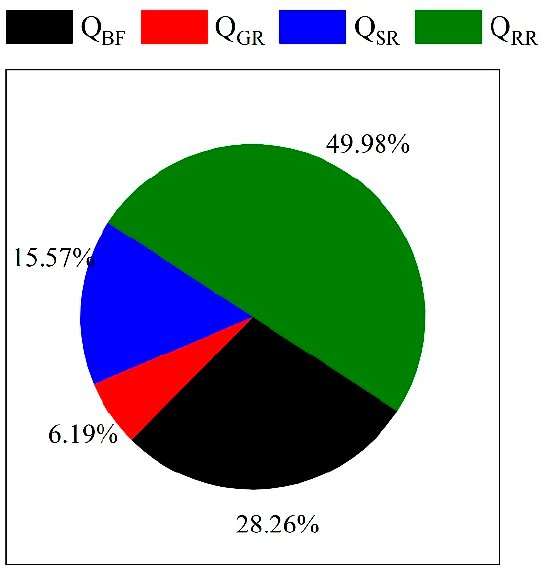
Figure 9. Mean annual contributions of each runoff component to the total runoff.